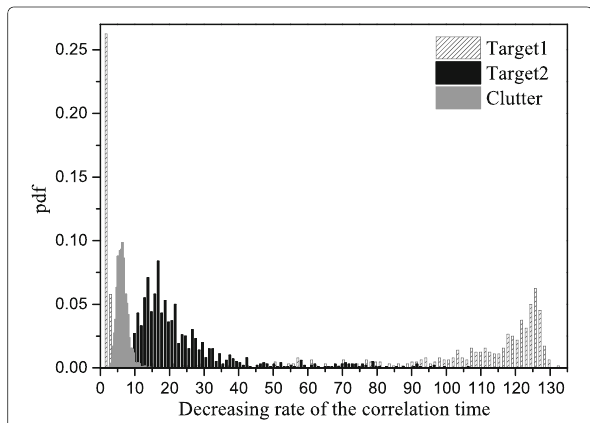
Fig. 3 Statistical results of the correlation time for the sea clutter and targets